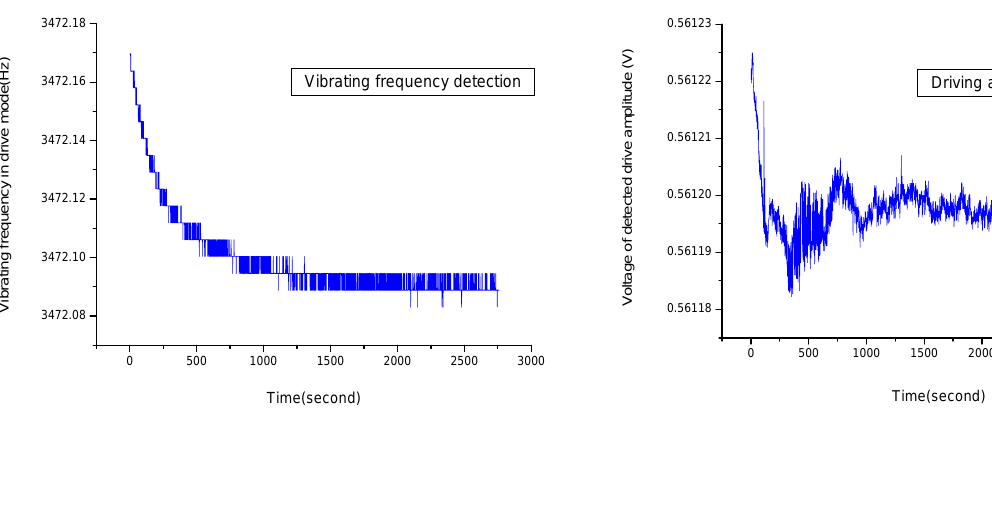
Figure 4. Vibrating frequency and amplitude in drive